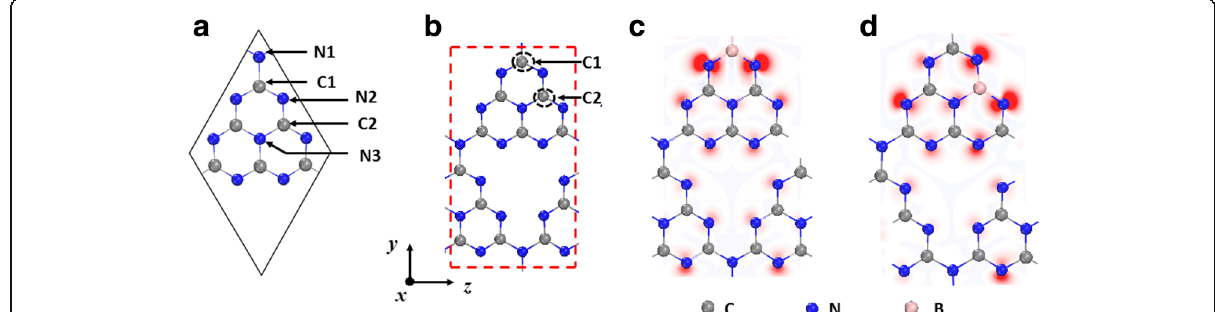
Fig. 1 a Schematic representation of pristine gh-C 3 N 4 . There are two inequivalent C atoms (C1 and C2) and three inequivalent N atoms (N1, N2, and N3). b The tetragonal 28 a.u. cell of gh-C 3 N 4 is used here to simulate the B-doped gh-C 3 N 4 system (corresponding to 8.33% doping concentration). The black dashed circles indicate the possible B doping sites. c , d The optimized structures of B C1 @gh-C 3 N 4 and B C2 @gh-C 3 N 4 , respectively. Distributions of charge density of spin-up state minus spin-down state for B C1 @gh-C 3 N 4 and B C2 @gh-C 3 N 4 are also shown here. The red and blue colors label the spin-up and spin-down charges,